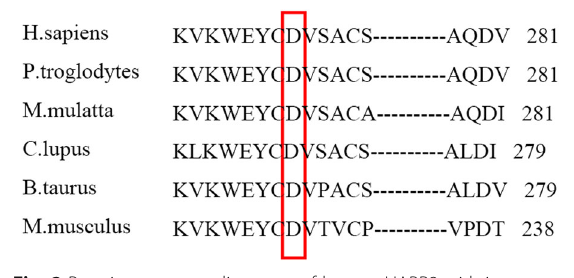
Fig. 2 Protein sequence alignment of human HABP2 with its orthologs. The residue of the missense mutation p.Asp272Glu (p.D272E) is highly conserved in Euteleostomi from H.sapiens to